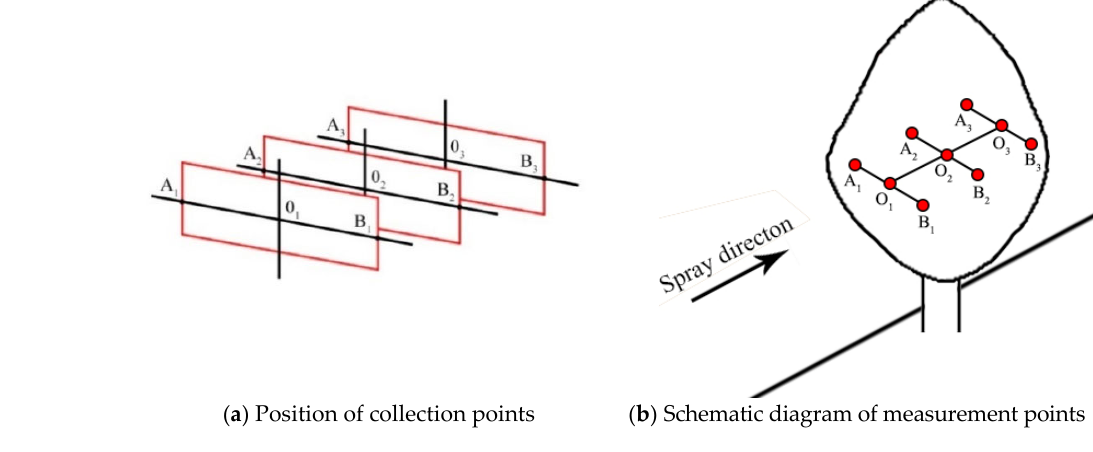
Figure 5. Layout of droplet collection points.